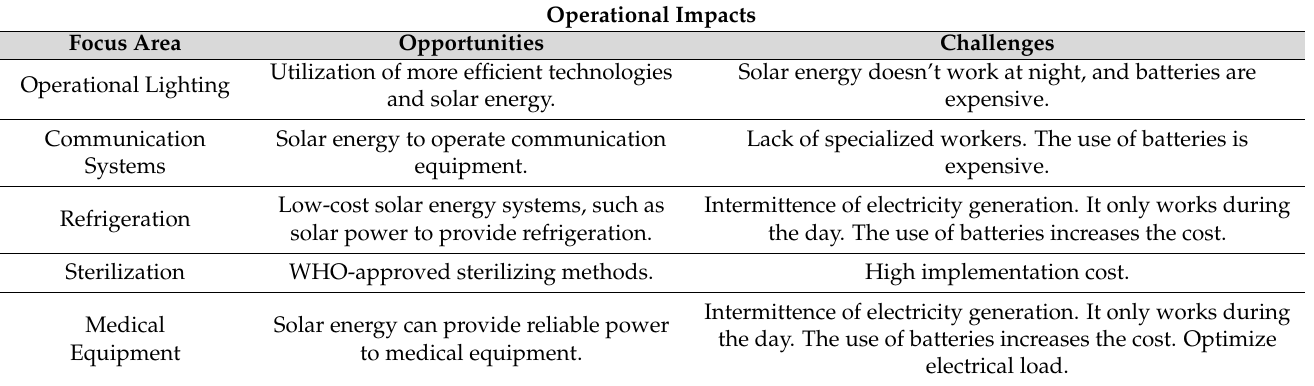
Table 1. Summary of opportunities and challenges for the use of solar energy in health facilities— operational impacts.